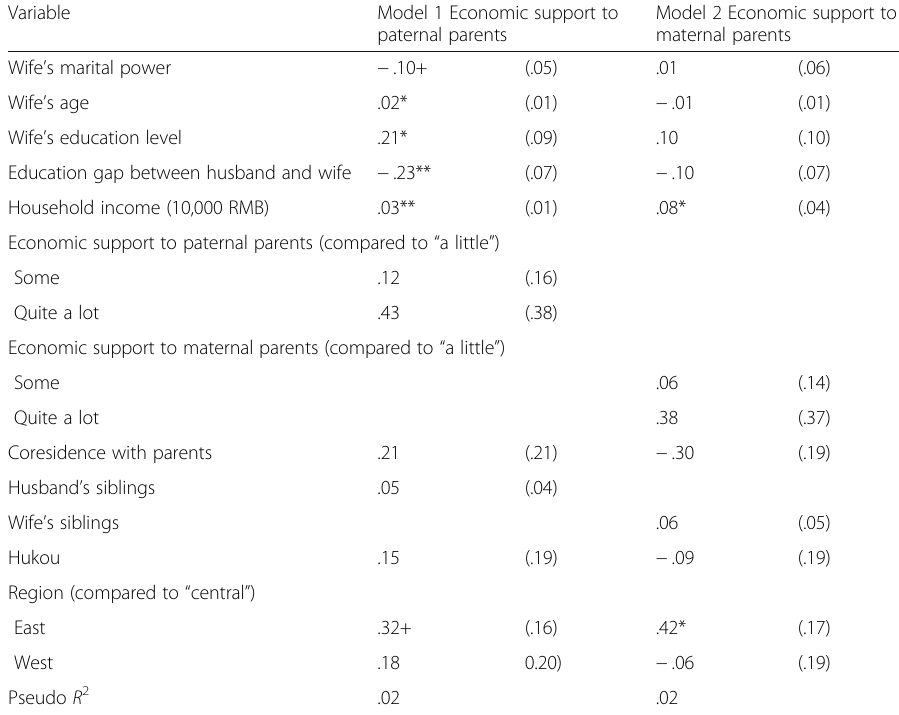
Table 2 The influence of women ’ s marital power on intergenerational resource allocation in the family N = 1139 Variable Model 1 Economic support to paternal